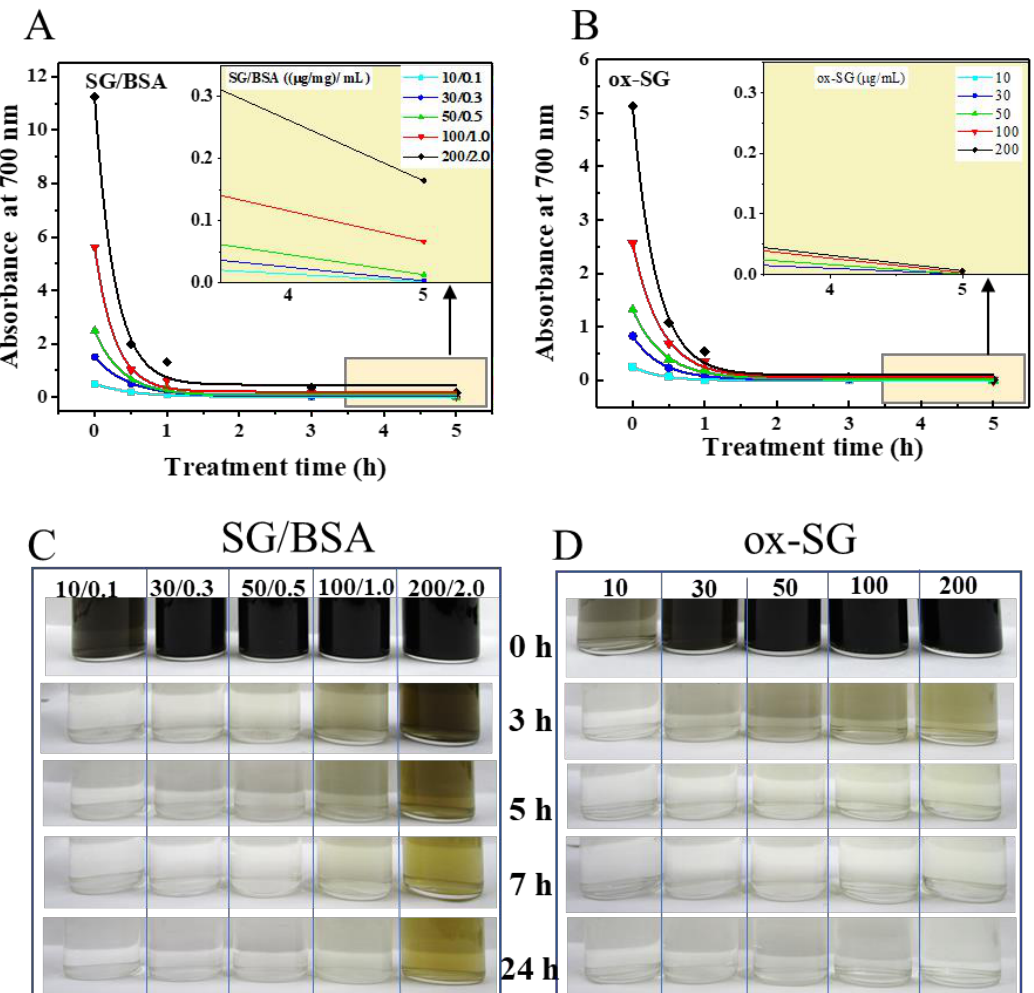
Figure 5. The effect of BSA dispersant on the degradation of SG-CNTs by 2.26 wt% NaClO at 70 °C. The absorbance at 700 nm indicates the change in the amount of SG-CNTs during treatment with different concentrations of SG/BSA ( A ) and ox-SG ( B ). The inset figures in A and B are close-up views of the light-yellow parts in each figure. Images of glass bottles containing SG/BSA ( C ) and ox-SG ( D ) dispersions with different concentration of CNTs following treatment with NaClO for 0−24 h. The concentrations in the legend represent the concentrations of ox -SG (µg/mL) and SG/BSA (µg or mg/mL).